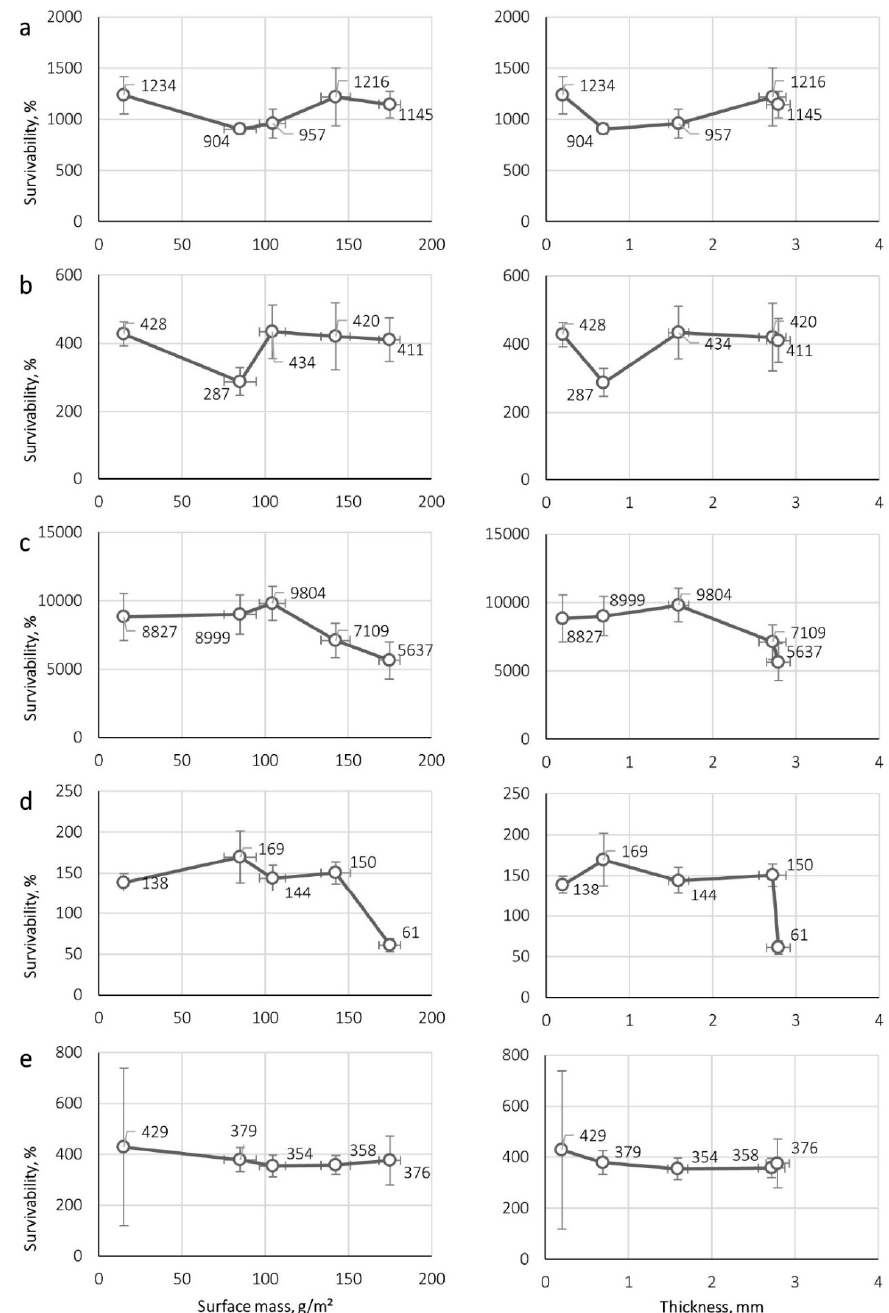
Figure 2. Dependence of the survivability of microorganisms on nonwovens on the mass per unit area (left) and the thickness of nonwoven (right) for ( a ) E. coli , ( b ) S. aureus , ( c ) B. subtilis , ( d ) C. albicans , ( e ) A. niger .